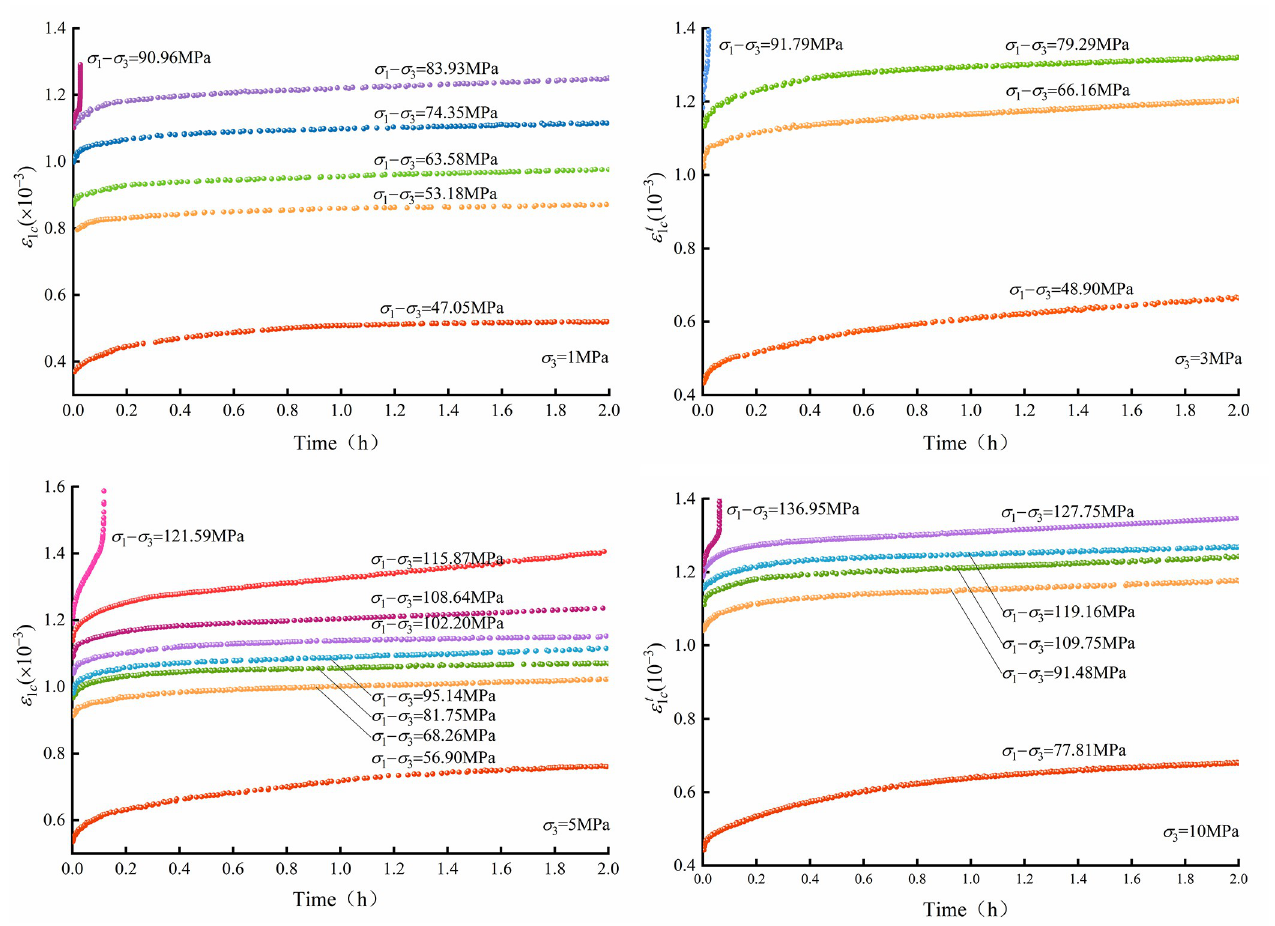
Fig 14. Axial creep crack strain results of micritic bioclastic limestone from triaxial multilevel creep tests with different confining pressures.